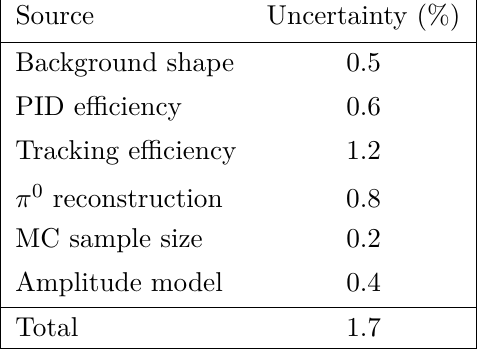
Table 11 . Systematic uncertainties in the BF